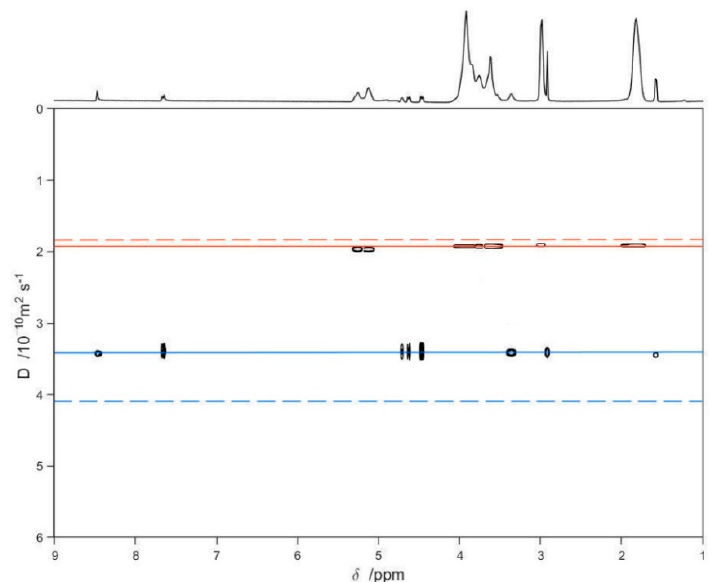
Figure 5. 2D DOSY-NMR measurements on the 10 mM D 2 O solutions of LVF, SBE- β -CD, and LVF/SBE- β -CD 1:1 inclusion complex. The horizontal axis represents the chemical shifts, whereas the vertical axis the diffusion coefficients; the black spots are the resonances of the aqueous solution of the inclusion complex spread in the second dimension according to their measured diffusion coefficient.